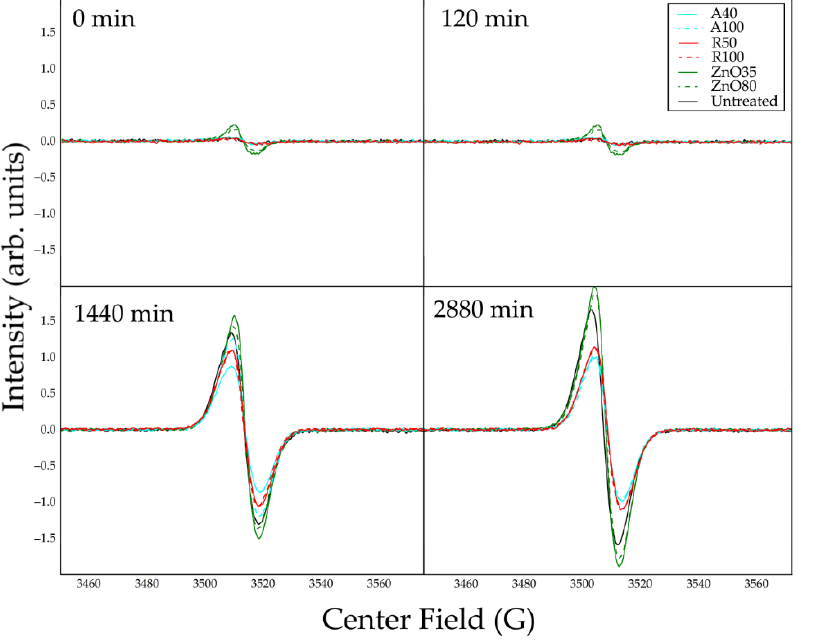
Figure 4. Radical activity in wood samples detected by electron paramagnetic resonance (EPR) for untreated control and samples treated with anatase 40 nm (A40), anatase 100 nm (A100), rutile 50 nm (R50), rutile 100 nm (R100), ZnO 35–45 nm (ZnO35), ZnO 80–200 nm (ZnO80), and untreated samples (control); before and after 120, 1440, and 2880 min of UV exposure (340